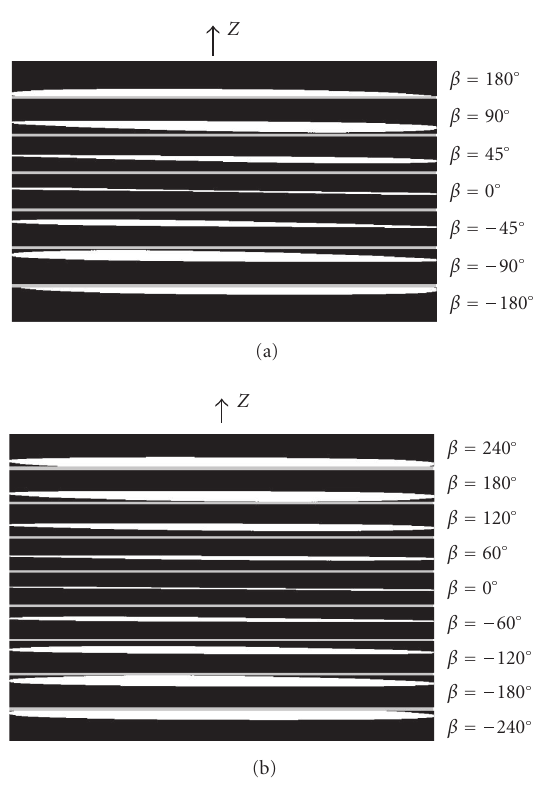
Figure 2: The schematic diagram showing the projection of image plane as a function over view angle at (a) helical pitch 33 / 64 : 1; and (b) helical pitch 63 / 64 : 1. (The vertical direction is parallel to the rotation axis of a CT gantry, while the horizontal direction corresponds to the latitudinal direction of the